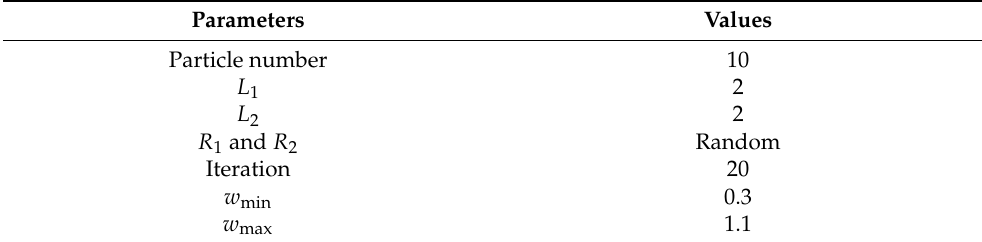
Table 3. Parameters and settings of PSO